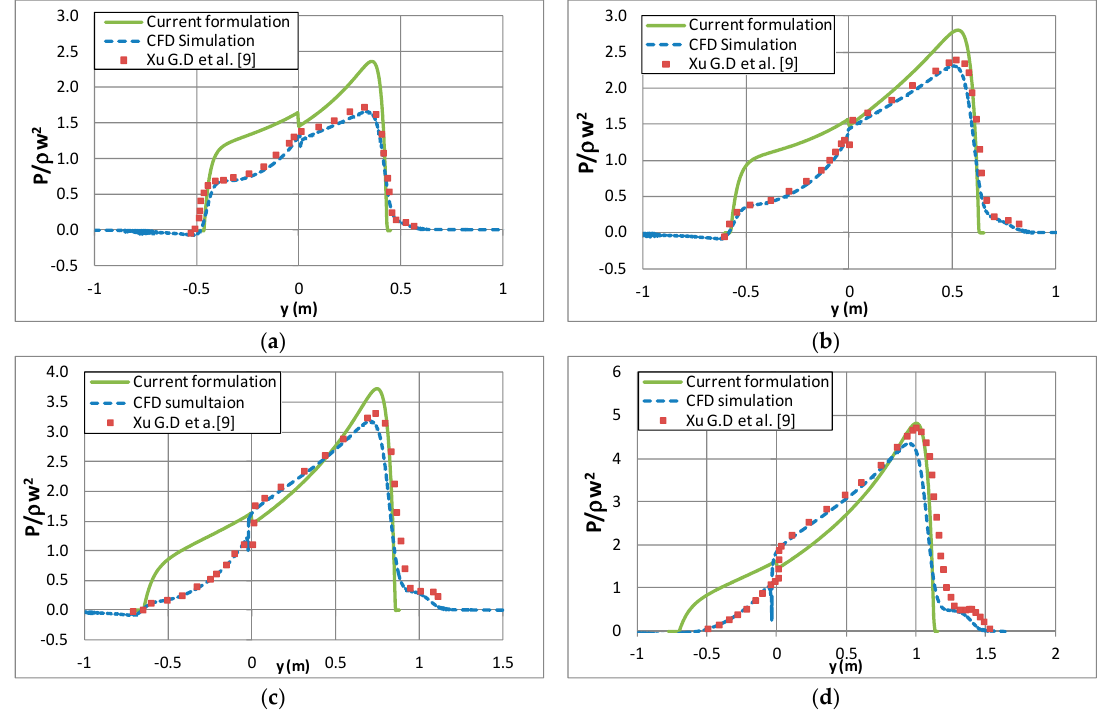
Figure 13. Pressure distribution with rotational velocity, w = 5 m/s, ω = − 2.5 rad/s, β = 45°, Vcg = 0.25 m and φ 0 = − 10°. ( a ) z 0 = 0.3 m. ( b ) z 0 = 0.4 m. ( c ) z 0 = 0.5 m. ( d ) z 0 = 0.6 m.